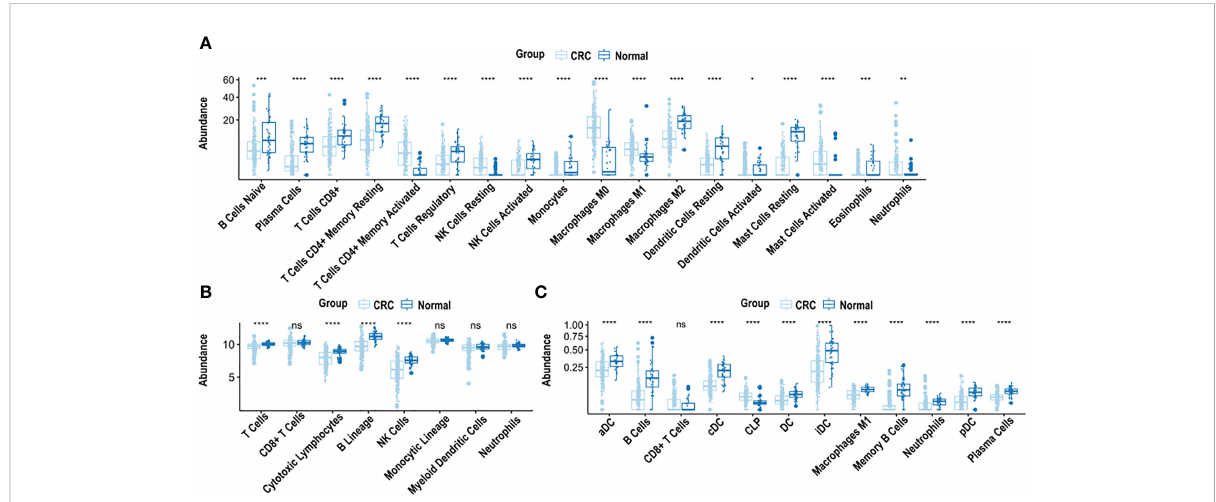
FIGURE 1 Analysis of immune cell composition of CRC samples using CIBERSORT, xCell and MCP-counter. (A) Immune cell abundance in CRC tissue compared to normal adjacent colon tissue, based on CIBERSORT analysis. (B) Immune cell abundance in CRC tissue compared to normal adjacent colon tissue, based on MCP-counter analysis. (C) Immune cell abundance in CRC tissue compared to normal adjacent colon tissue, based on xCell analysis. CRC was compared to normal tissue using the Wilcoxon test. ****p < 0.0001, ***p < 0.001, **p < 0.01, *p < 0.05, n.s. non-signi fi